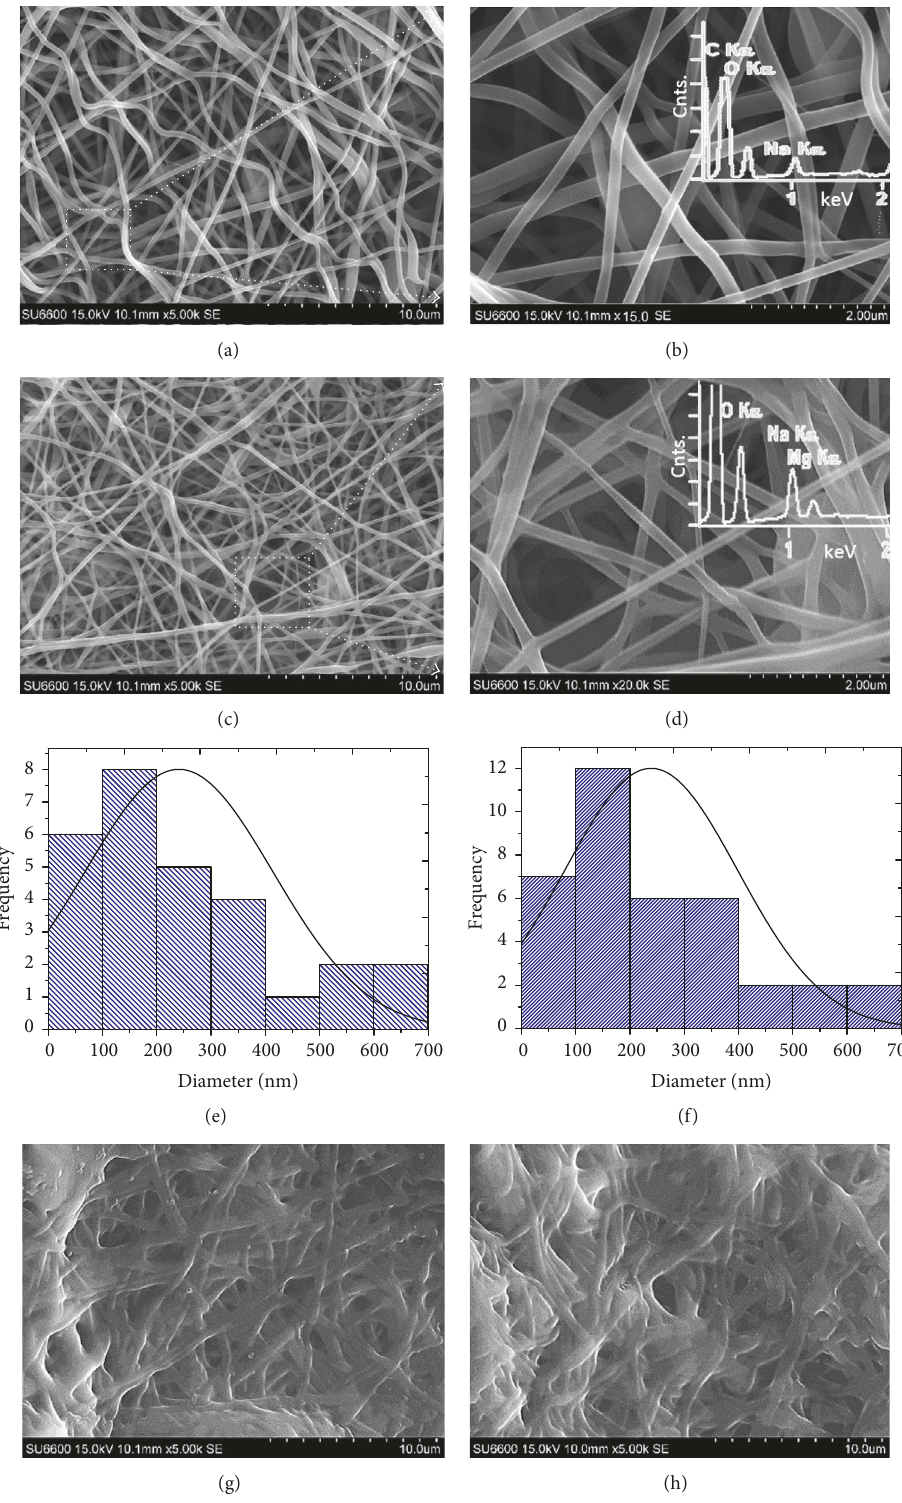
Figure 2: Morphology of electrospun alginate-based scaffolds. (a, b) show SEM images of the alginate-based scaffolds. (c, d) show SEM images of the alginate/MgO scaffolds (with 10% (w/w) MgO). Histograms of frequency versus fibre diameter for the (e) alginate-based fibres and (f) alginate/MgO fibres. (g, h) show SEM images of the cross-linked alginate scaffolds. Insets in (b) and (d) are the graphs of the number of counts versus energy derived from EDX